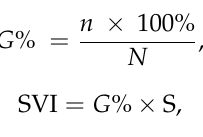
Figure 1. Schematic diagram of the experimental setup used in this study. In this germination study, Bambara groundnut seeds were germinated on trilayer filtration paper in plastic boxes to sustain humidity. Each germination experiment used twenty seeds (weighing ~5 g) and was carried out in five replicates. As per ISTA rules, our seeds were incubated at 25 ◦ C for eight days with the relative humidity (RH) maintained between 60% and 65%. A total of 10 to 15 mL of de-ionized (DI) water was added every 24 h to maintain moisture for germination. Germinated seeds were counted on the 5th day (known as germination potential); another count was carried out on the 8th day after sowing (known as germination percentage (%)) [31], similarly using Equation (1), but with a different germination day. A seed was considered germinated if its radicle length was more than 2 mm [32]. In addition, the root and shoot lengths of each germinated seed were measured on the 11th day. Germination % and seed vigor index (SVI) were calculated using Equations (1) [21] and (2) [33],